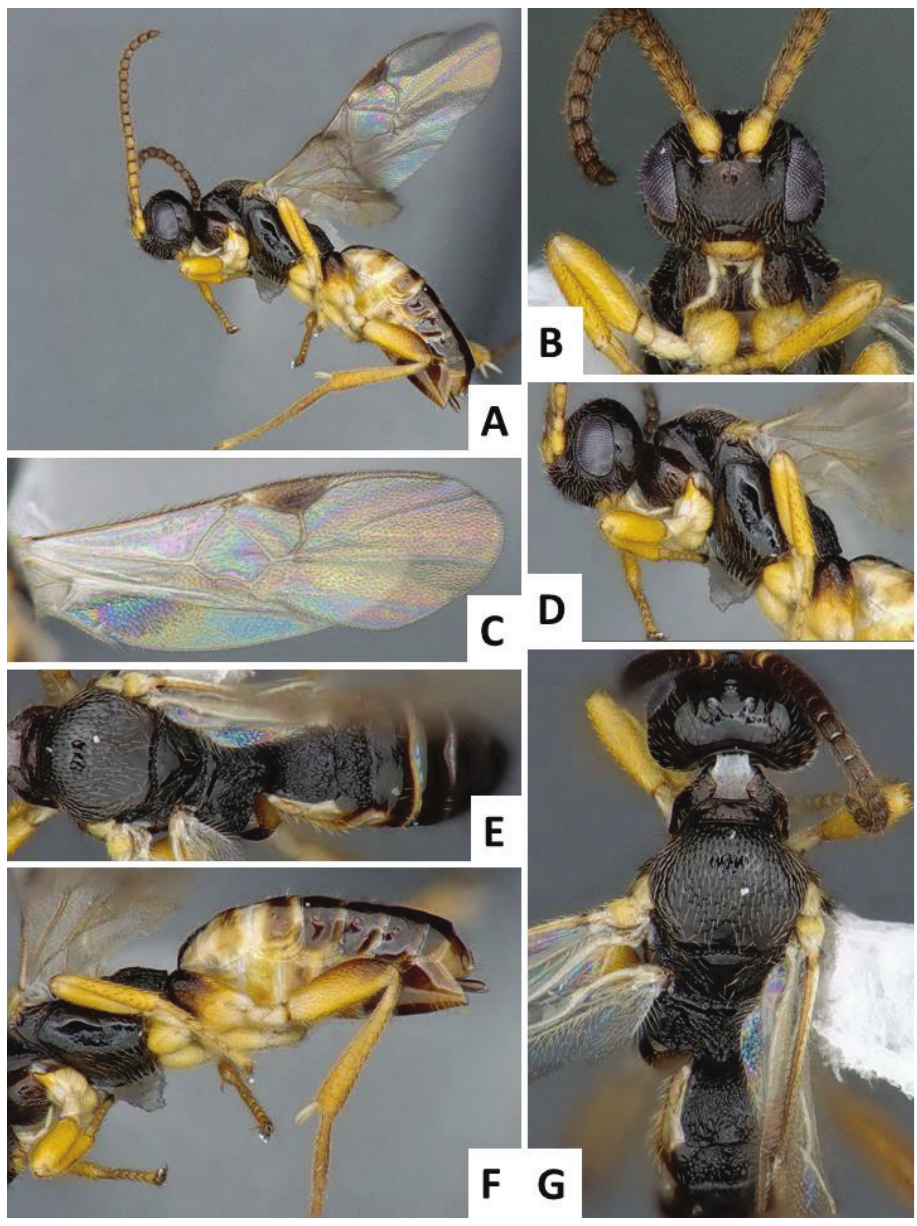
Figure 7. Cotesia flavipes , female specimen from Mombasa, Kenya. A Habitus, lateral view B Head, frontal view C Wings D Head and mesosoma, lateral view E Mesosoma and metasoma, dorsal view F Mesosoma and metasoma, lateral view G Head, mesosoma and tergites 1-2, dorsal